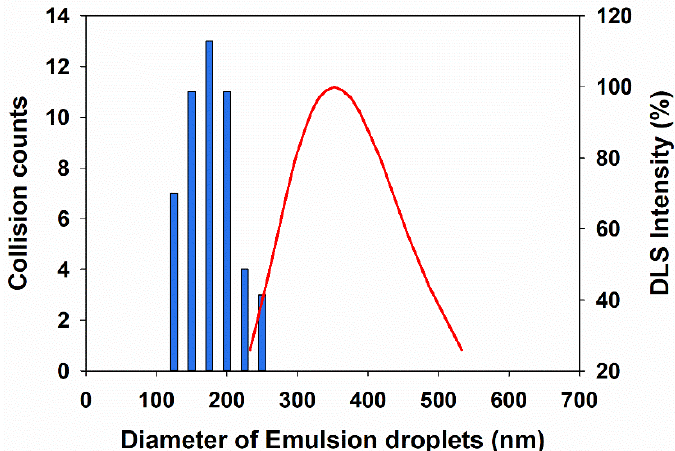
Figure 5. Comparison of the size distribution between the single W/O (water-in-oil) emulsion collision method (blue bars) and DLS measurement (red